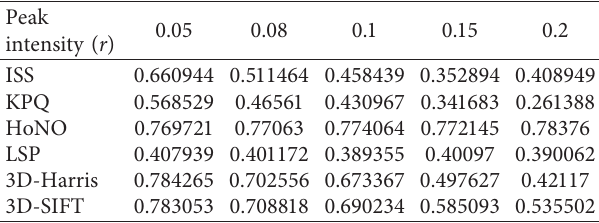
of the key point noise Figure 5: Gaussian noise-repetition rate change curve. Table 6: The resolution repetition rate r detection algorithm on the laser scanner data